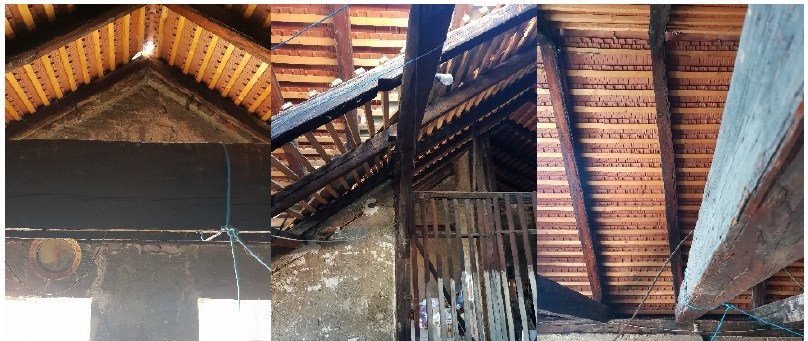
Figure 5. Damages to the timber roof structure are due to the failure of the chimney. (Photo credit: Mislav Stepinac). Figure 6. Damages to the timber roof structure are due to a lack of (out of plane) bracing system. (Photo credit: Jure Barbali ć ).